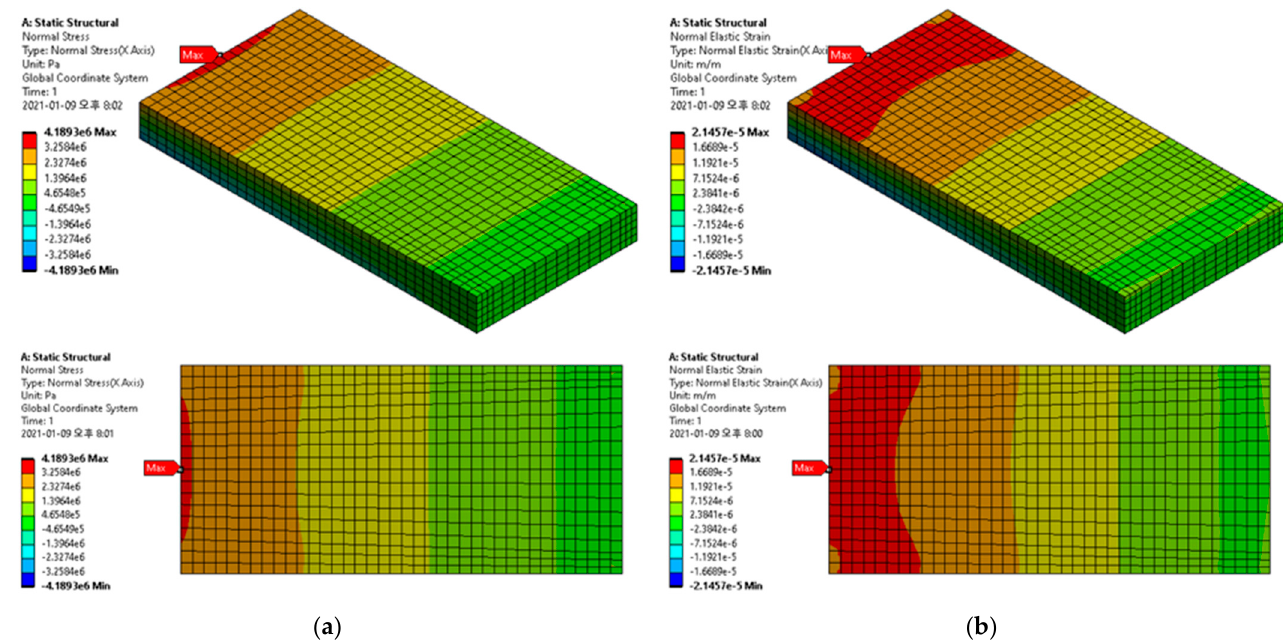
Figure 3. FEA results of the unimorph sensing element ( a ) stress and ( b ) strain.